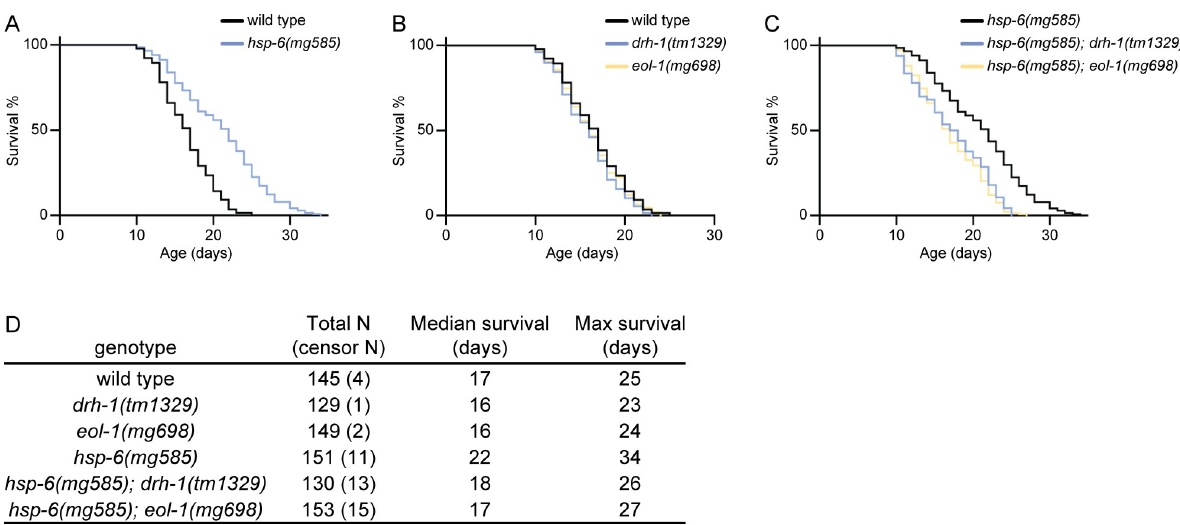
Fig 7. Decoupling of the Eri response to mitochondrial dysfunction also abrogates the life span enhancement of mitochondrial mutations, but not wild-type life span. (A) The hsp-6(mg585) mitochondrial mutation extends life span. (B) drh-1(tm1329) or eol-1(mg698) single mutants do not extend or shorten wild life span. (C) drh-1(tm1329) or eol-1(mg698) suppresses the extension of life span caused by the hsp-6(mg585) mutation. (D) Median and maximal survival and number of animals surveyed and censored due to losses during the month-long assay. The underlying numerical data can be found in S1